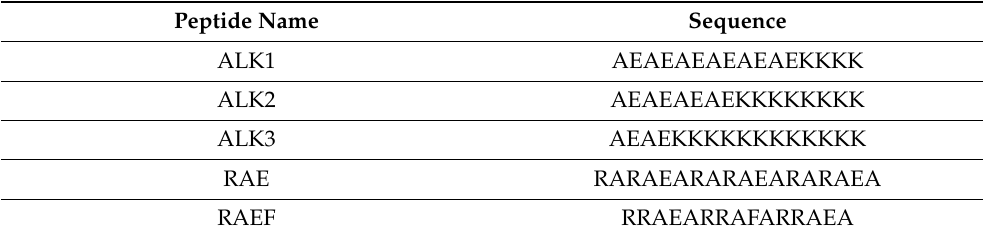
Table 1. Peptide names and sequences. Amino acid single letter abbreviations are used: alanine (A), glutamic acid (E), lysine (K), arginine (R), and phenylalanine (F). Peptide